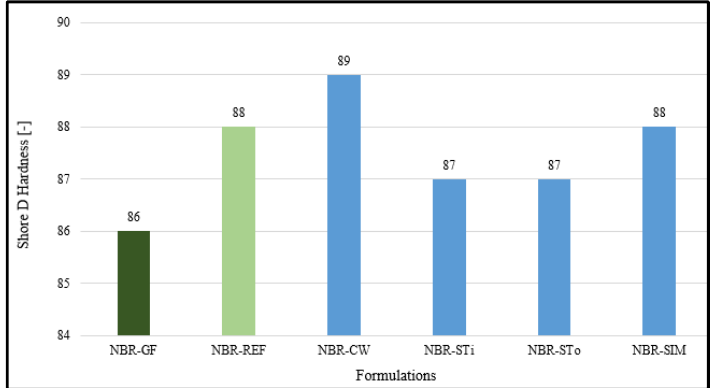
Figure 3. Shore D hardness of the epoxy coatings with different fillers.